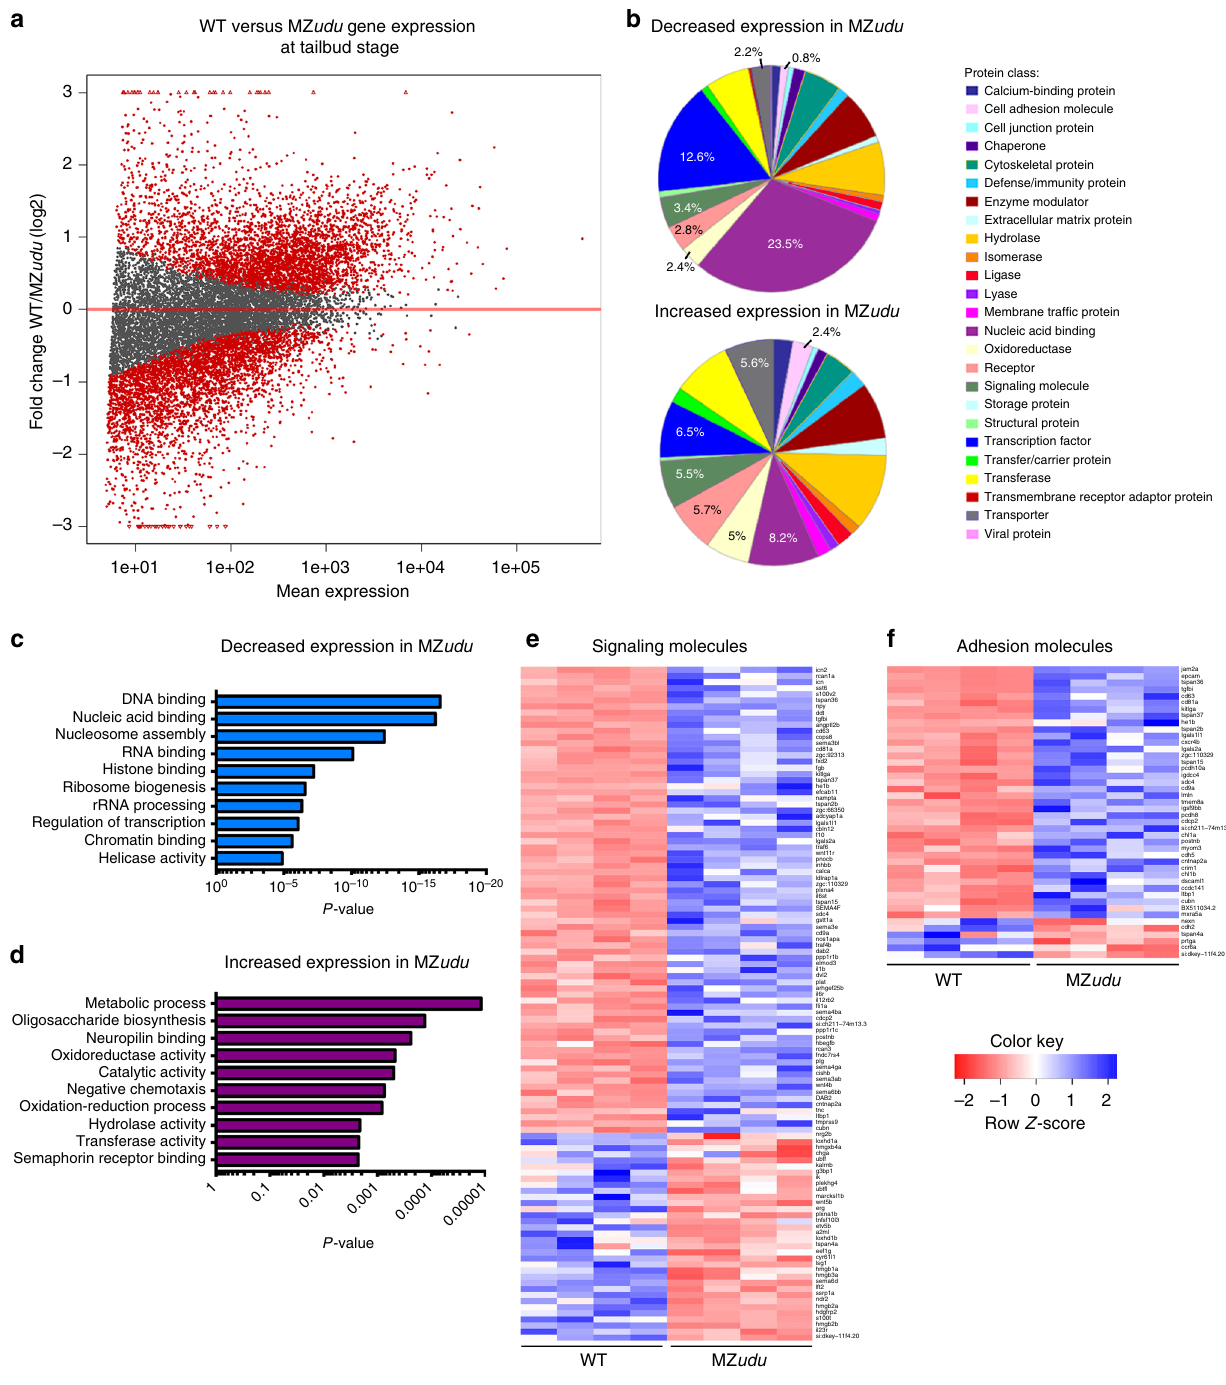
Fig. 5 Loss of Gon4l results in large-scale gene expression changes. a Plot of gene expression changes in MZ udu mutants compared to WT at tailbud stage as assessed by RNA sequencing. Red dots indicate genes expressed at signi fi cantly different levels than WT ( p ≤ 0.05, at least twofold change in transcript level). b Protein classes encoded by differentially expressed genes with decreased (top graph) or increased (bottom graph) expression in MZ udu mutants. Percentages indicate the number of genes within a given class/total number of genes with increased or decreased expression, respectively. c – d P -values of the top ten most enriched gene ontology (GO) terms among genes with decreased ( c ) or increased ( d ) expression in MZ udu − / − gastrulae compared to WT. e – f Heat maps of differentially expressed genes annotated as encoding signaling ( e ) or adhesion molecules ( f ). The four columns represent two biological and two technical replicates for each WT and MZ udu − /